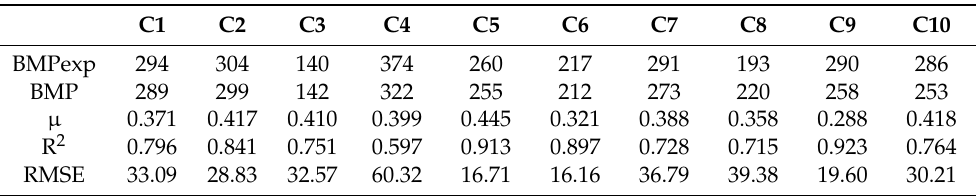
Table 4. Parameters of the first-order kinetic model corresponding to each experiment of the mixture design and respective experimental